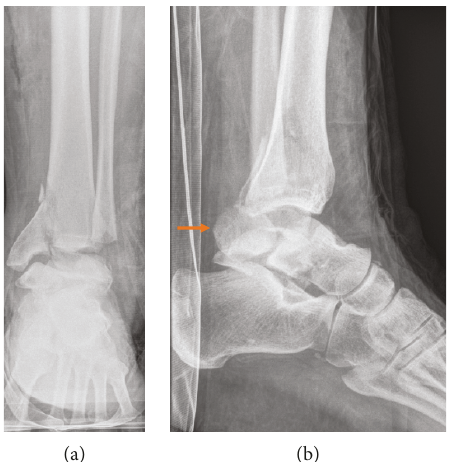
Figure 1: (a) Preoperative AP view of the left ankle: vertical shear fracture of medial distal tibia, horizontal lateral malleolus fracture, and talus fracture. (b) Preoperative lateral view of the left ankle: posterior dislocation of the distal fi bula, talar neck fracture, and distal tibia fracture. The array shows the distal fi bula dislocated posterior of the tibia and